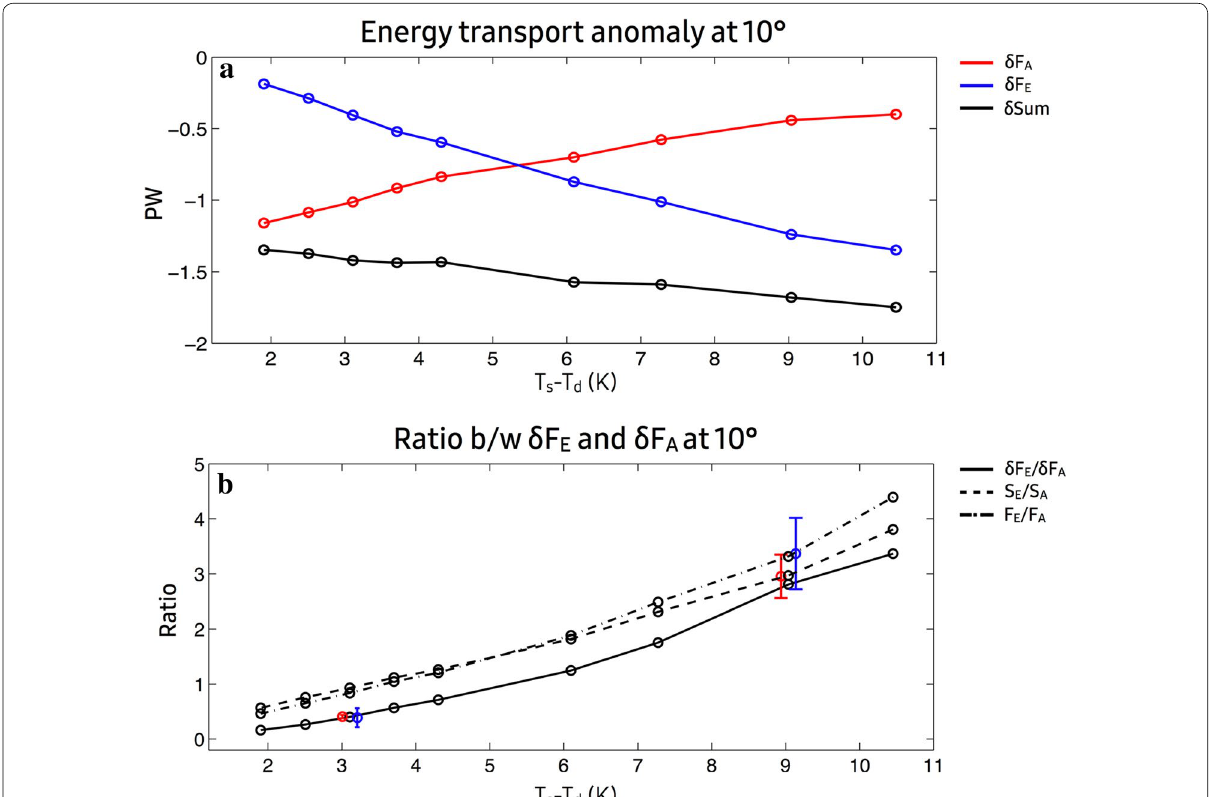
Fig. 3 a The meridional energy transport anomaly by the atmosphere δF A (red) and by the Ekman flow δF E (blue), and the sum (black) in PW, and b the ratio of the changes in Ekman to atmospheric energy transport δF E / δF A (black solid), the ratio of Ekman to atmospheric gross stability in CNT S E / S A (black dashed), and the ratio of Ekman to atmospheric meridional energy transport in CNT F E / F A (black dash-dot), as a function of T s corresponds to the experiments with varying forcing amplitudes F S0 and blue to those with varying forced latitude bands φ 0 . All estimates are the average anomalies at 10°S and